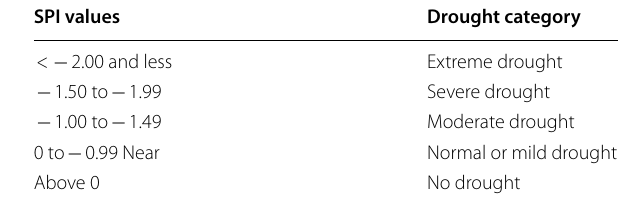
Table 2 Classification of VCI values in terms of drought VCI value (%)